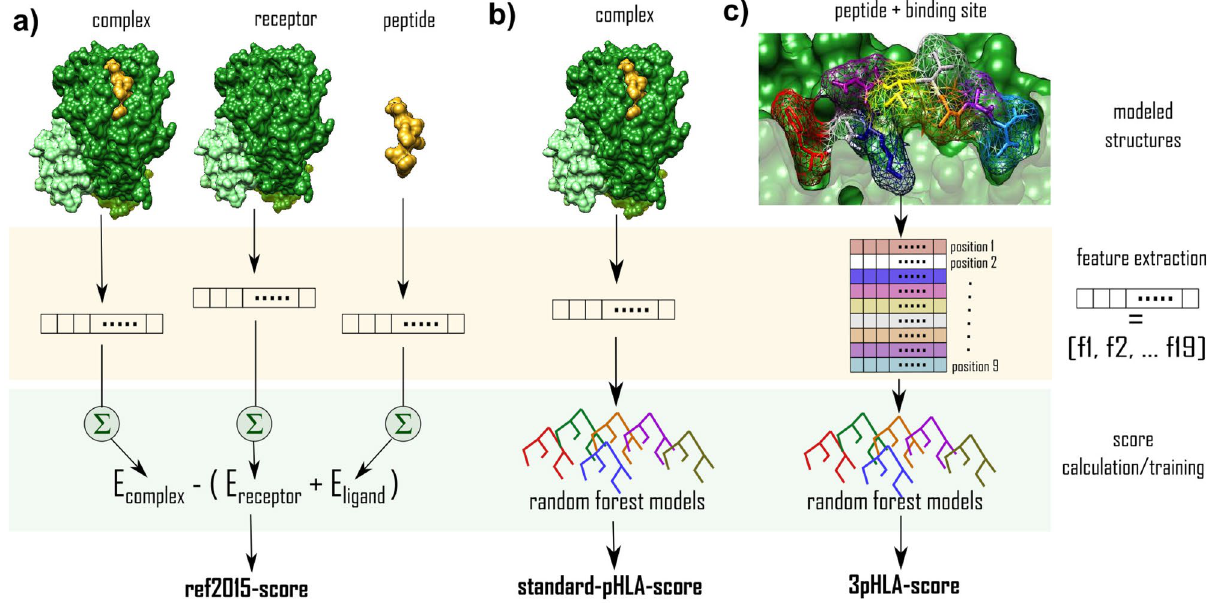
Figure 1. Description of three different protocols for approximating the binding affinity of a pHLA complex. Example input structures are visualized in the first row. The second row (orange stripe) shows the feature extraction phase of the scoring where ref2015 energy terms are extracted (Supplementary Table S1). The score calculation and training phase are indicated in row 3 (green stripe). (a) For ref2015-score, standard ref2015 energies are calculated for the complex, receptor, and ligand. They are then used to derive the binding energy with the Eq. (1) (b) For standard-pHLA-score, standard features are extracted from the complex; scoring is done using trained random forest regression models. (c) For the 3pHLA-score, per-peptide-position features are extracted from the structure of the complex; scoring is done using trained random forest regression